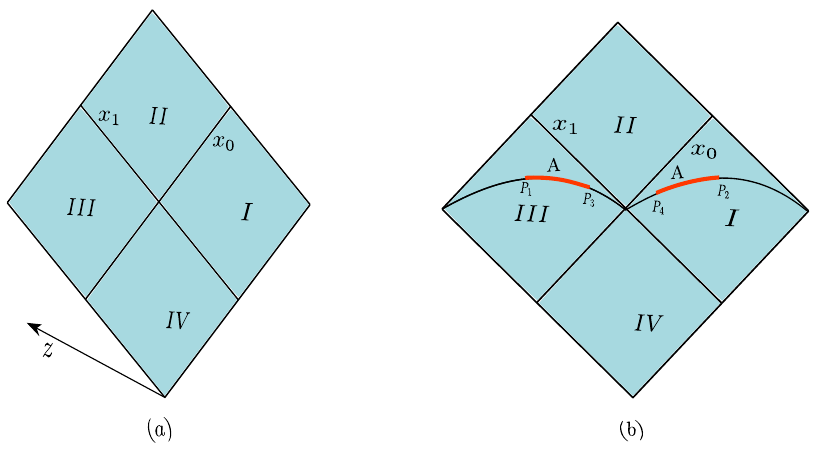
Figure 3 . ( a ) Different regions of the BTZ black string. Region I and III are Rindler wedges. ( b ) Endpoints of the interval A on both sides of the Rindler wedges (figure modified from that in [57]). III in figure 3(a) by analytically continuing the time t → t + iπ . This is the